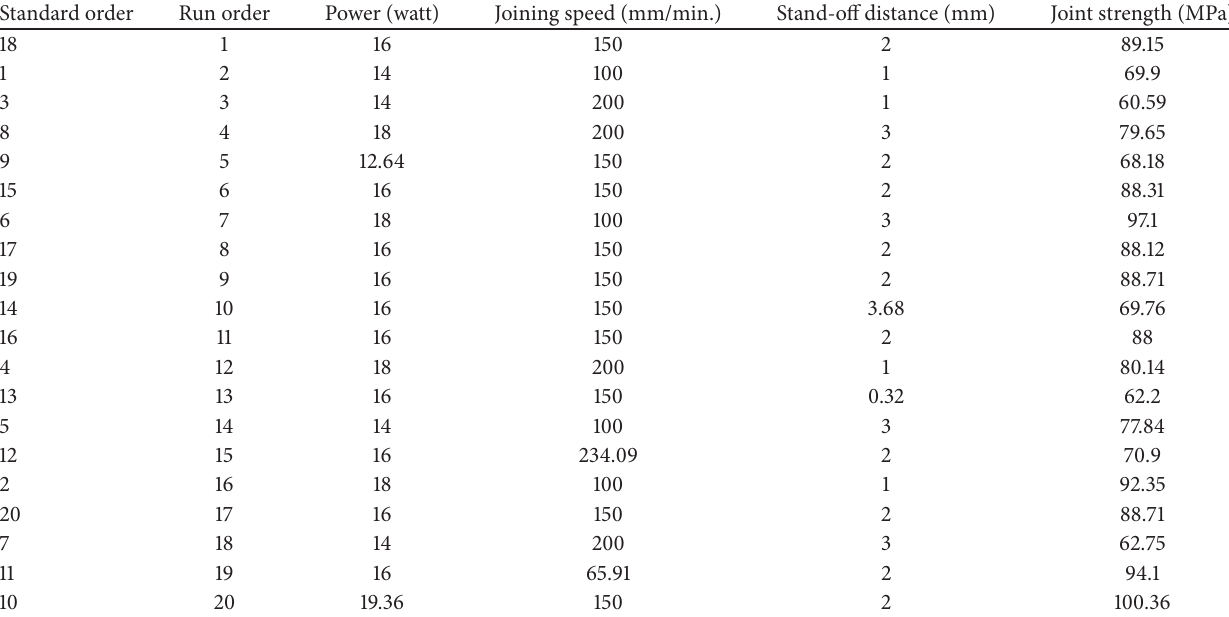
Table 3: Design matrix and experimental results.